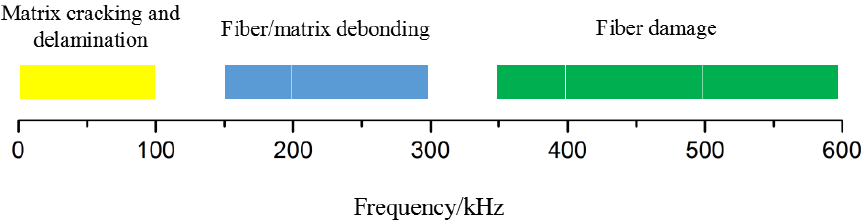
Figure 13. Summary of frequency range for damage mechanisms.